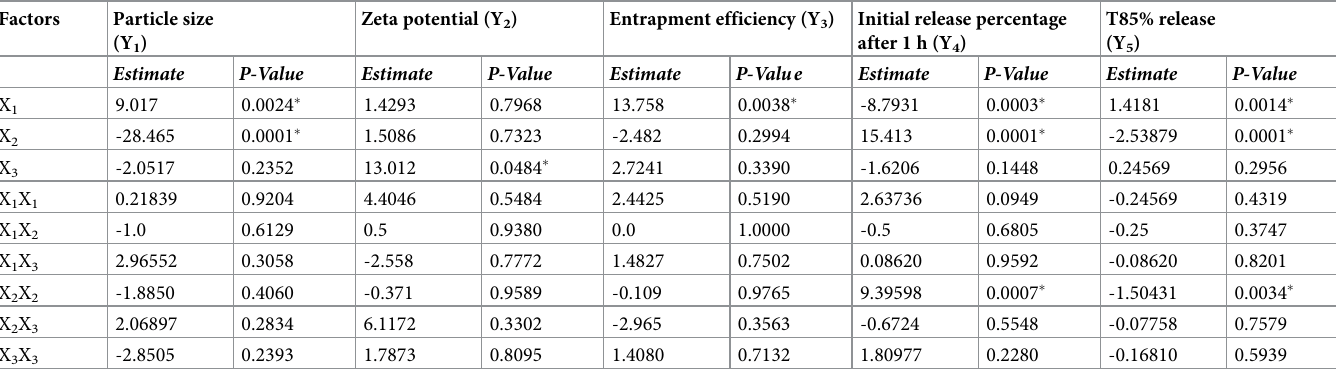
Table 2. Statistical analysis of variance (ANOVA) of the responses (Y 1 - Y 5 )